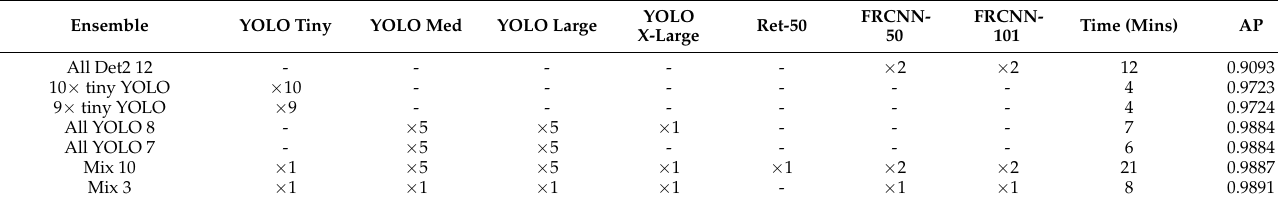
Table 3. Composition and AP values of best performing ensembles overall.